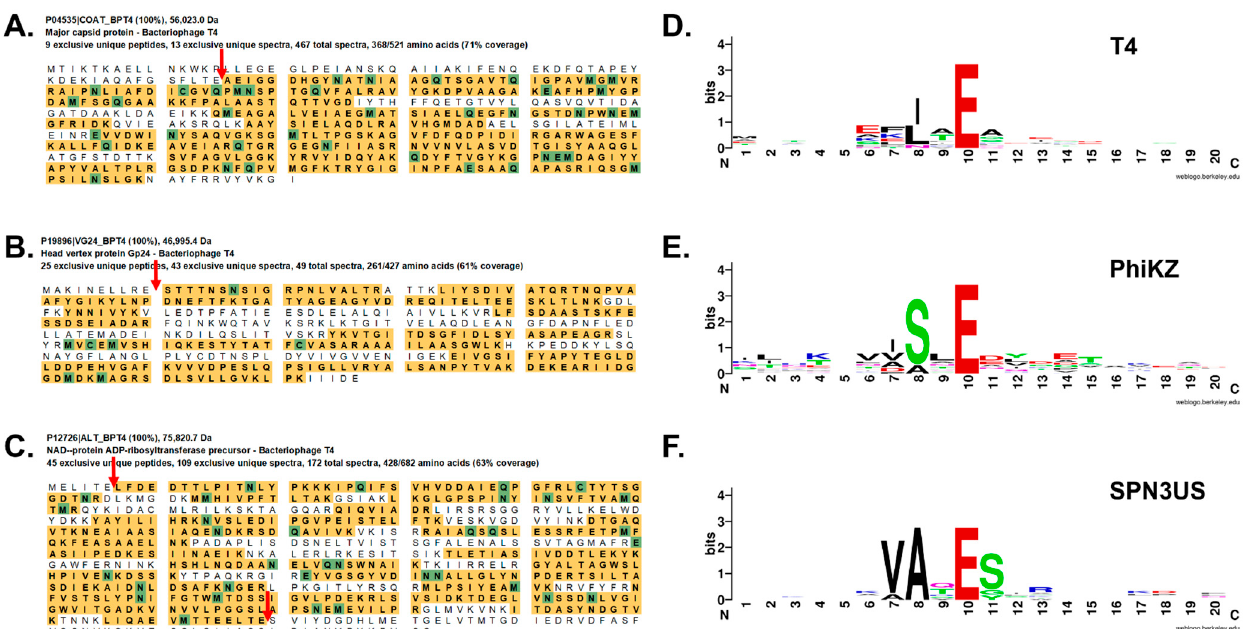
Figure 3. Proteolytic cleavage of head proteins by the prohead proteases of T4 and giant phages. Mass spectral protein sequence coverage of T4 head proteins ( A ) gp23, ( B ) gp24 and ( C ) Alt, with their respective gp21 cleavage sites indicated by red arrows. Giant phages ϕ KZ and SPN3US have diverged homologies to T4 gp21 and also cleave their head proteins C -terminal to a glutamyl residue after a short sequence motif. Protein sequence logos of the regions flanking the prohead protease cleavage sites in head proteins in ( D ) T4, ( E ) ϕ KZ and ( F ) SPN3US. Sequence logos were created using WebLogo (https://weblogo.berkeley.edu/logo.cgi, accessed on 12 February 2022).